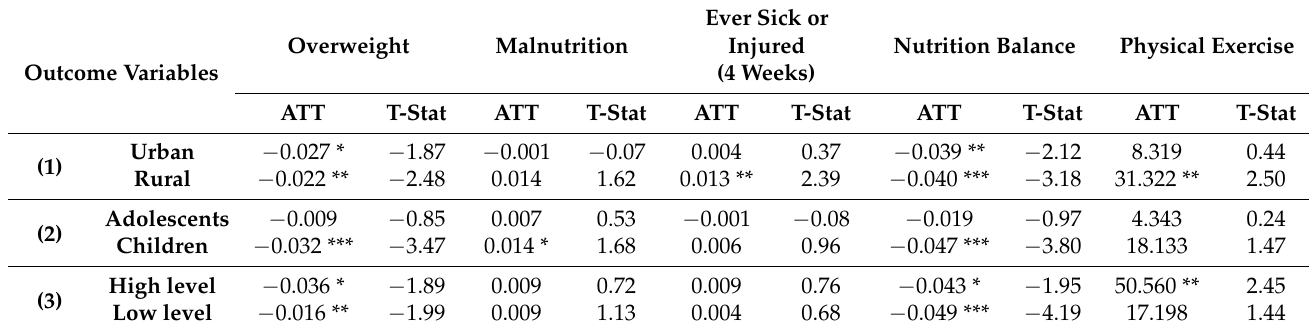
Table 14. Results of heterogeneity